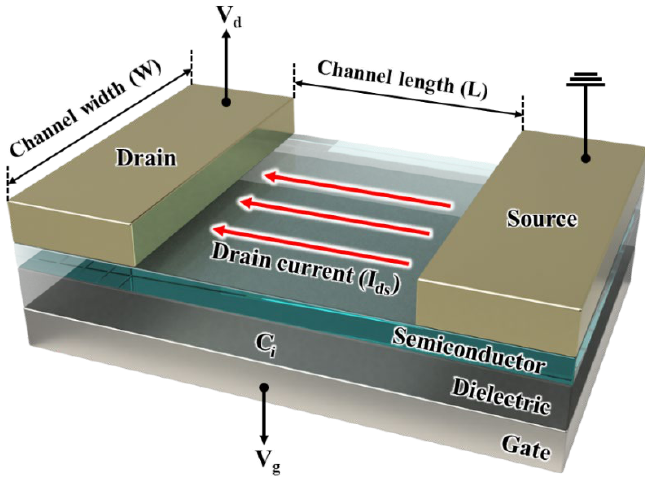
Figure 1. Scheme of OFET with bottom gate, top contact (BGTC).